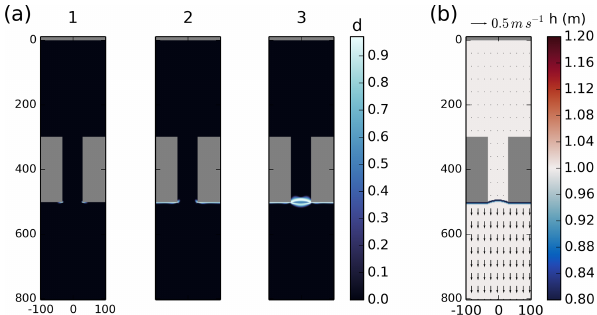
Figure 5. (a) Damage field at the surface forcing indicated by points 1, 2 and 3 in Fig. 4 during the formation of the downstream ice arch. (b) Sea ice thickness and drift following the formation of the downstream ice arch, while the ice bridge remains stable (Phase C).